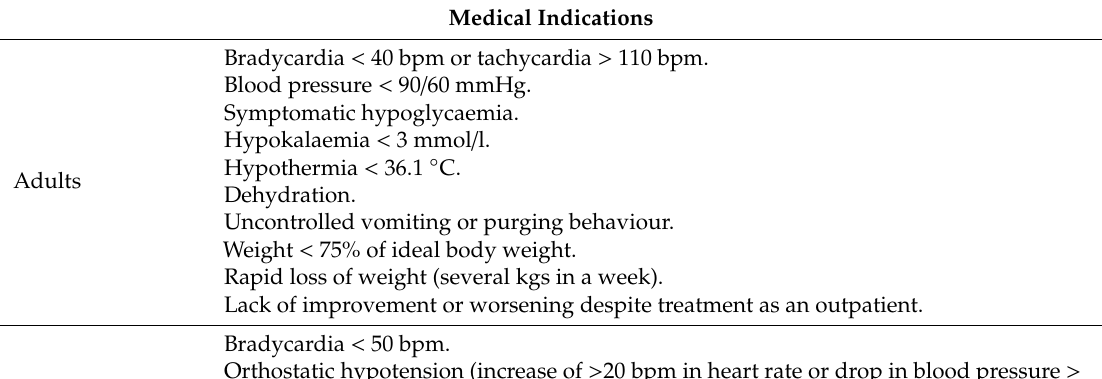
Table 3. Criteria for hospitalisation in anorexia nervosa. Medical Indications